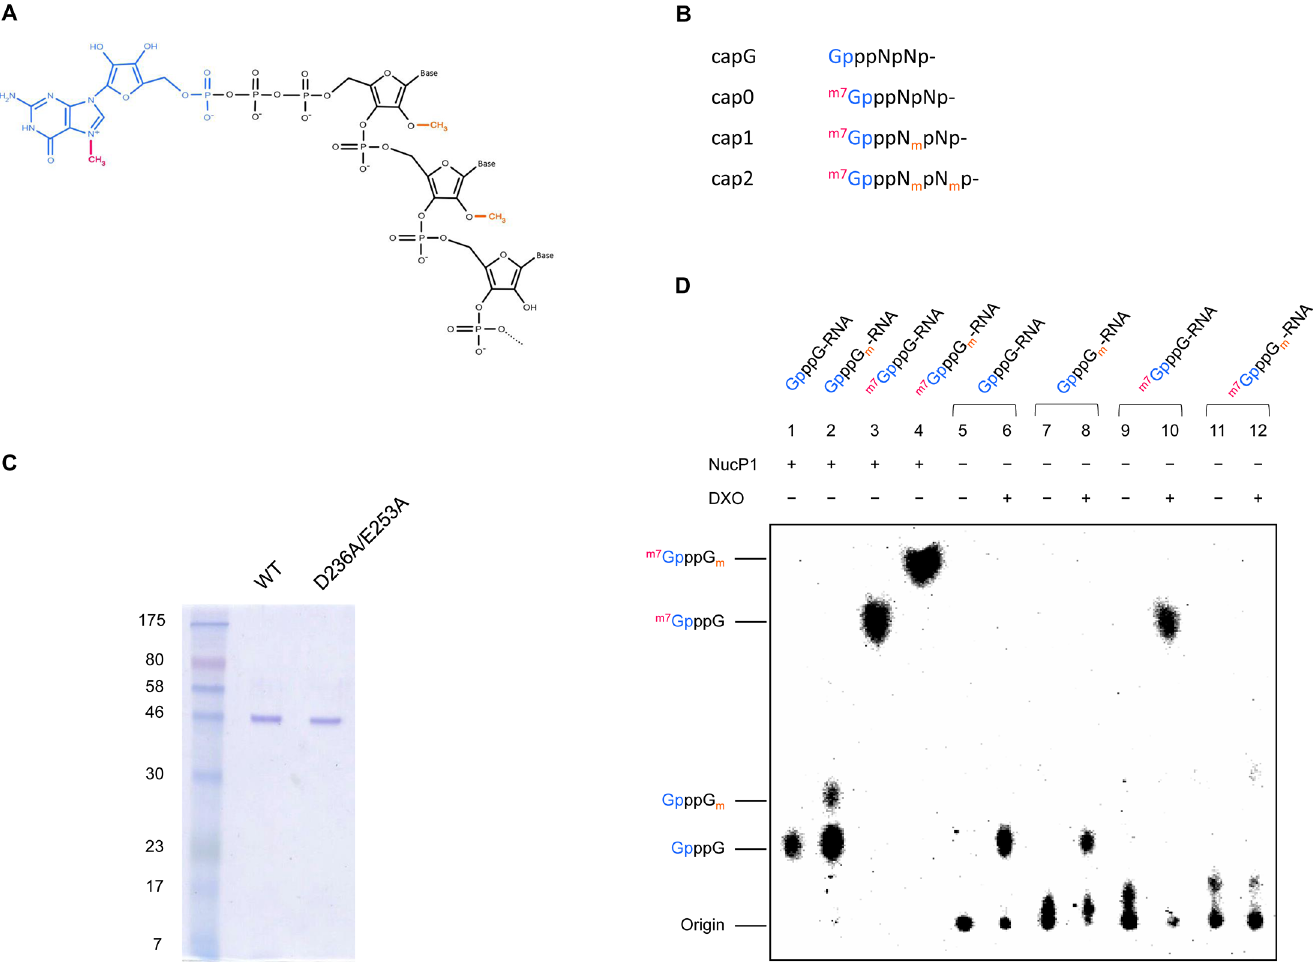
Fig 1. DXO hydrolyzes only capped RNAs without a 2’- O -methylation. (A) The RNA 5’ cap structure is composed of a guanosine (blue) linked to the RNA (black) through a 5’-5’ triphosphate bridge. The subsequent N7-methylation of the guanosine (magenta) confers a positive charge to the cap structure. Additional 2’- O - methylations (orange) can be found on the first few nucleotides. (B) Nomenclature of the different cap structures. (C) Aliquots (2 μ g) of the purified preparations of DXO and mutant DXO protein (D236A/E253A) were analyzed by electrophoresis through a 12.5% polyacrylamide gel containing 0.1% SDS and visualized with Coomassie Blue Dye. The positions and sizes (in kDa) of the size markers are indicated on the left. (D) RNAs harbouring different cap structures were transcribed and capped (incorporation of [ α - 32 P]GTP) in vitro . They were then subjected to degradation by different enzymes, and reaction products were separated by thin layer chromatography. Lanes 1–4 show reaction products after treatment of differently capped RNAs with Nuclease P1. Degradation products after incubation of differently capped RNAs with purified DXO are shown in lanes 5–12. The origin of spotting and dinucleotide identities are listed on the left. NOTE: During the preparation of differently capped RNAs, only approximately 30% of GpppN-RNA was methylated to form GpppN m -RNA (lanes 2,7–8), resulting in a mixture of GpppN-RNA and GpppN m -RNA. Degradation products observed in lane 8 are due to the degradation of GpppN-RNA.